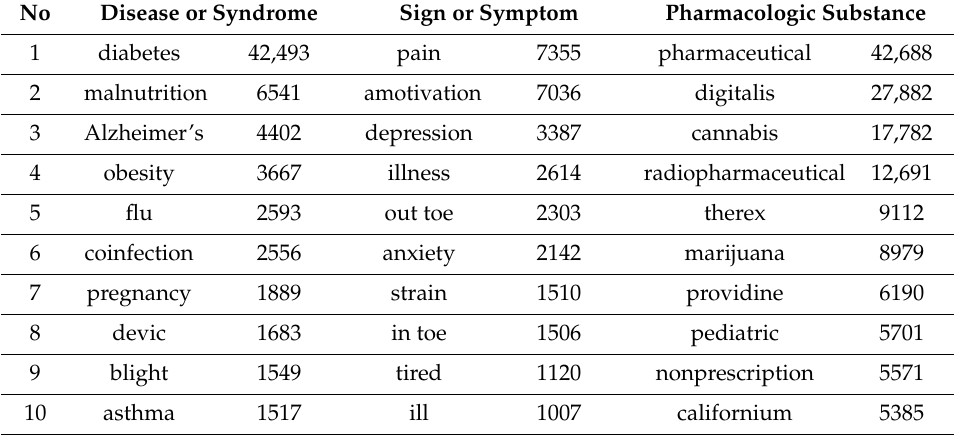
Table 2. Example of unique terms. Top most frequent terms per entity type.